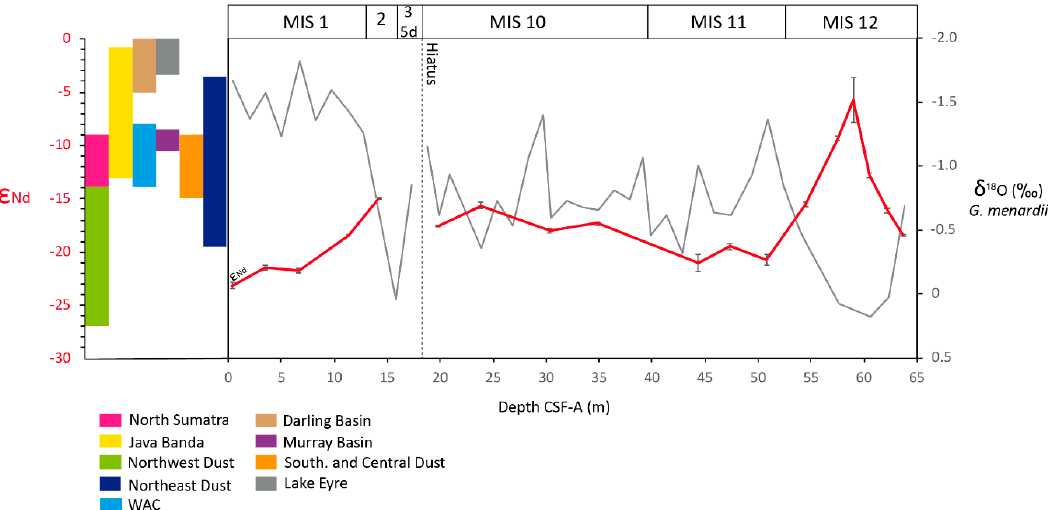
Figure 8. The last 500 ky evolution of neodymium isotopic ratios in clay-size sediment at Site U1461A. Neodymium isotope data ( ε Nd) are reported for the Hole U1461A (red line) with the inferred uncertainty on measurements. Additionally, shown for comparison are the average ε Nd compositions of the main potential source areas of fine-grained sediments to the studied site. The δ 18O curve measured on the G. menardii is also reported. WAC = West Australian Current.